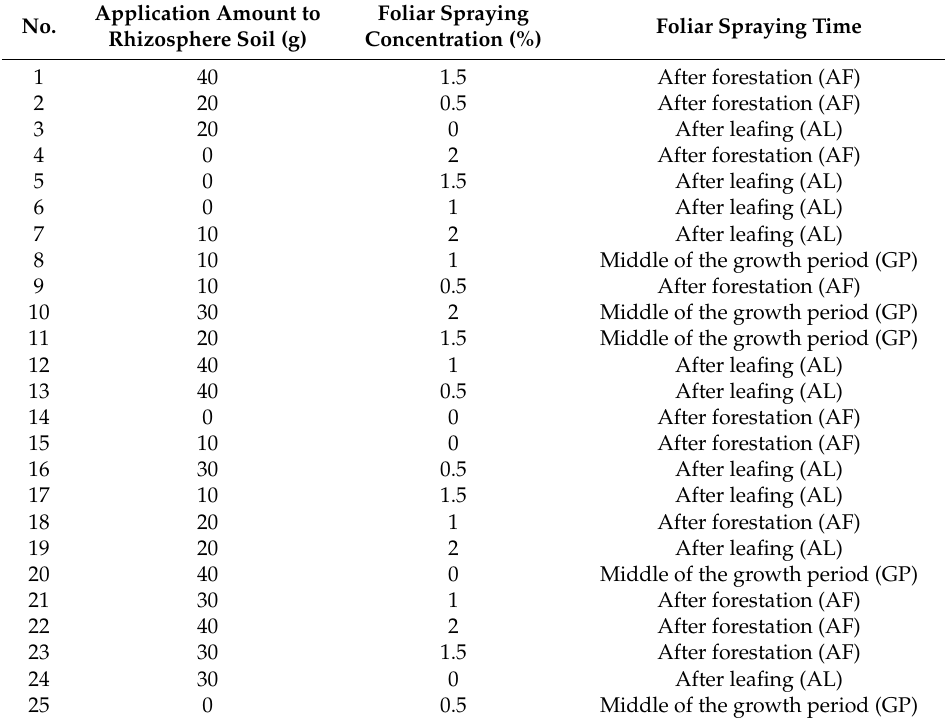
Table 3. The treatment groups L 25 (5 2 × 3 1 ). There were 2 factors with 5 levels and 1 factor with 3